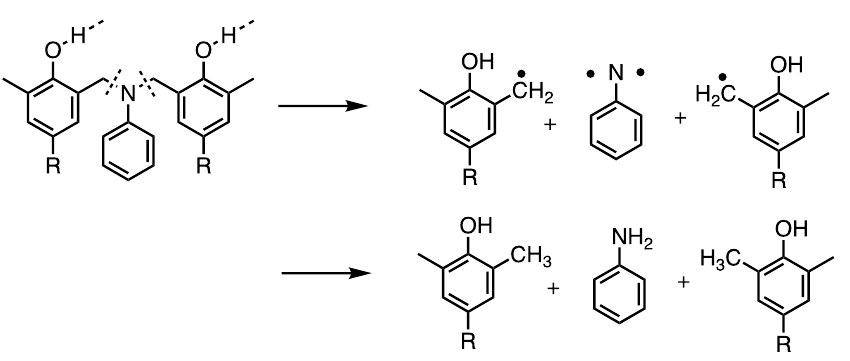
Figure 6. Degradation of non-hydrogen bonded nitrogen in the Mannich base of aniline-based benzoxazines to produce aniline [45].